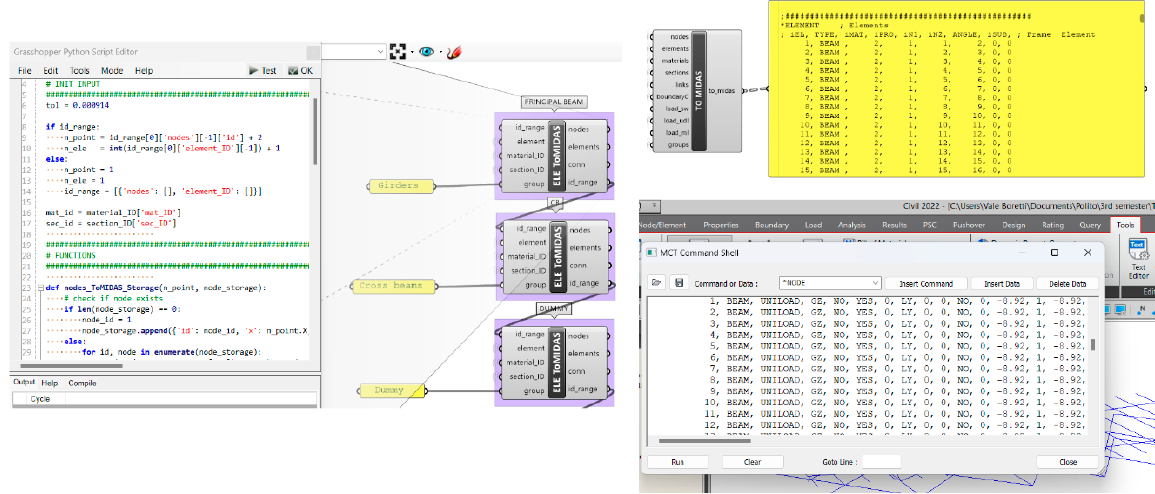
Figure 11. MCT file for model data transmission from Grasshopper to Midas Civil.